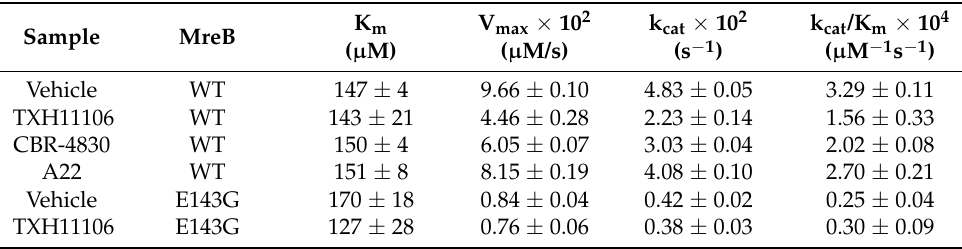
Table 4. Enzyme kinetics for the ATPase reaction of wild-type (WT) and E143G mutant EcMreB in the absence and presence of 30 µ M